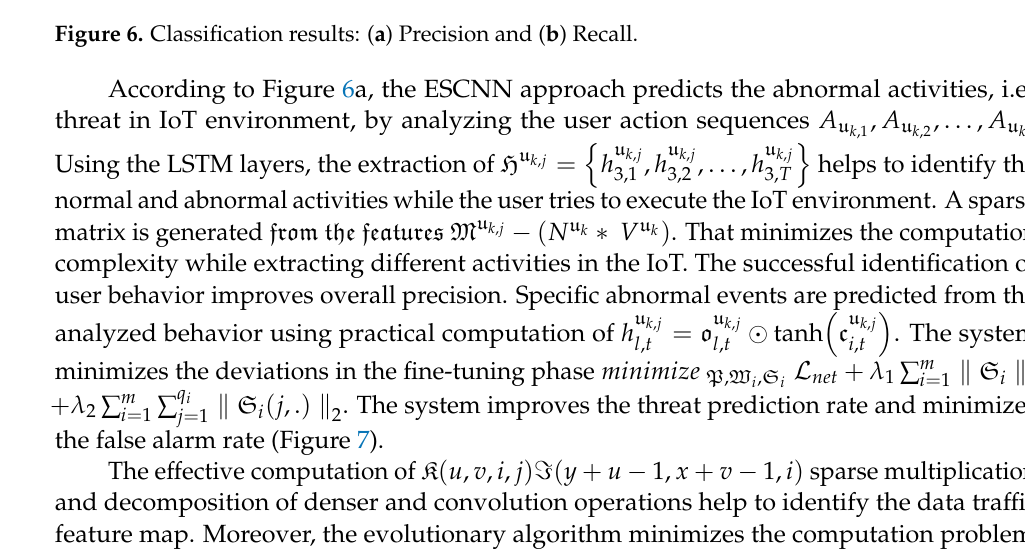
Figure 7. False Alarm Rate.